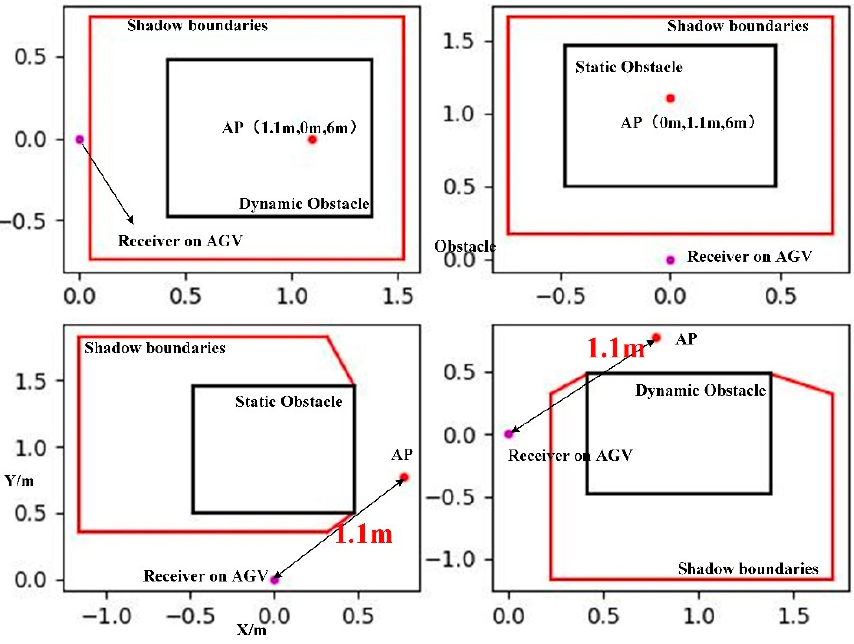
Figure 11. The shadow areas of APs within 𝐷 (cid:3046)(cid:3028)(cid:3033)(cid:3032)(cid:3047)(cid:3035)(cid:3045)